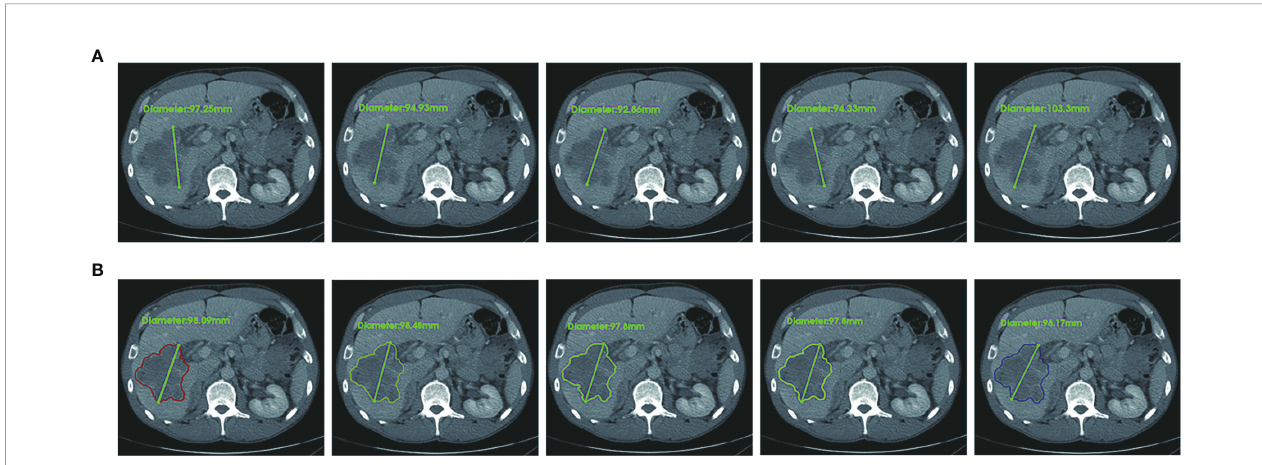
FIGURE 7 | An example case of manual and CAC measurements. In terms of RECIST 1.1 criteria, the longest diameter of a target lesion is measured on the image acquisition plane (axial plane in CT). (A) Upper row: fi ve manual measurements showed the mean value 96.5 ± 4.1 mm, range 92.7 mm to 103.3 mm, CV (coef fi cient of variance) 4.3%. (B) Lower row: fi ve CAC measurements showed the mean value 98.1 ± 0.3 mm, range 97.8 mm to 98.1 mm, CV 0.3%. The agreement of CAC measurements was substantially better than that of manual